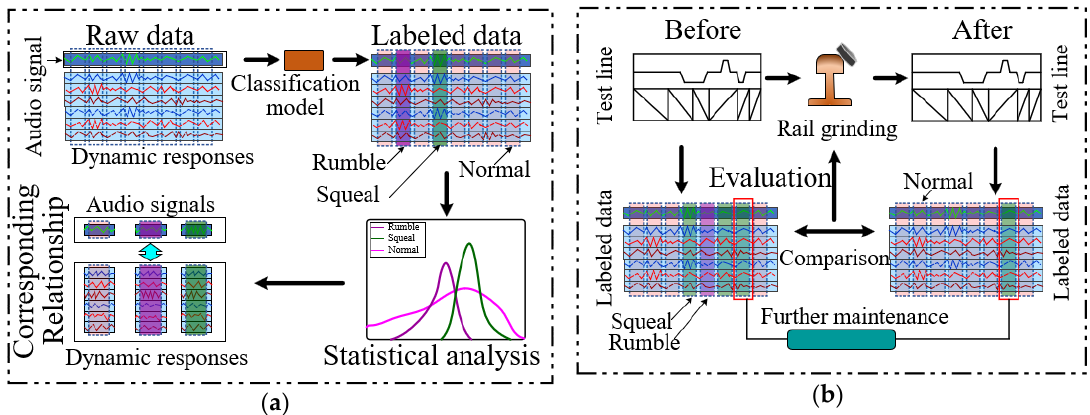
Figure 9. Schematics for case studies: ( a ) statistical analysis of vehicle interior noise and dynamic responses; ( b ) abnormal events detection and rail grinding effect evaluation using the XGBoost multi-classification model.